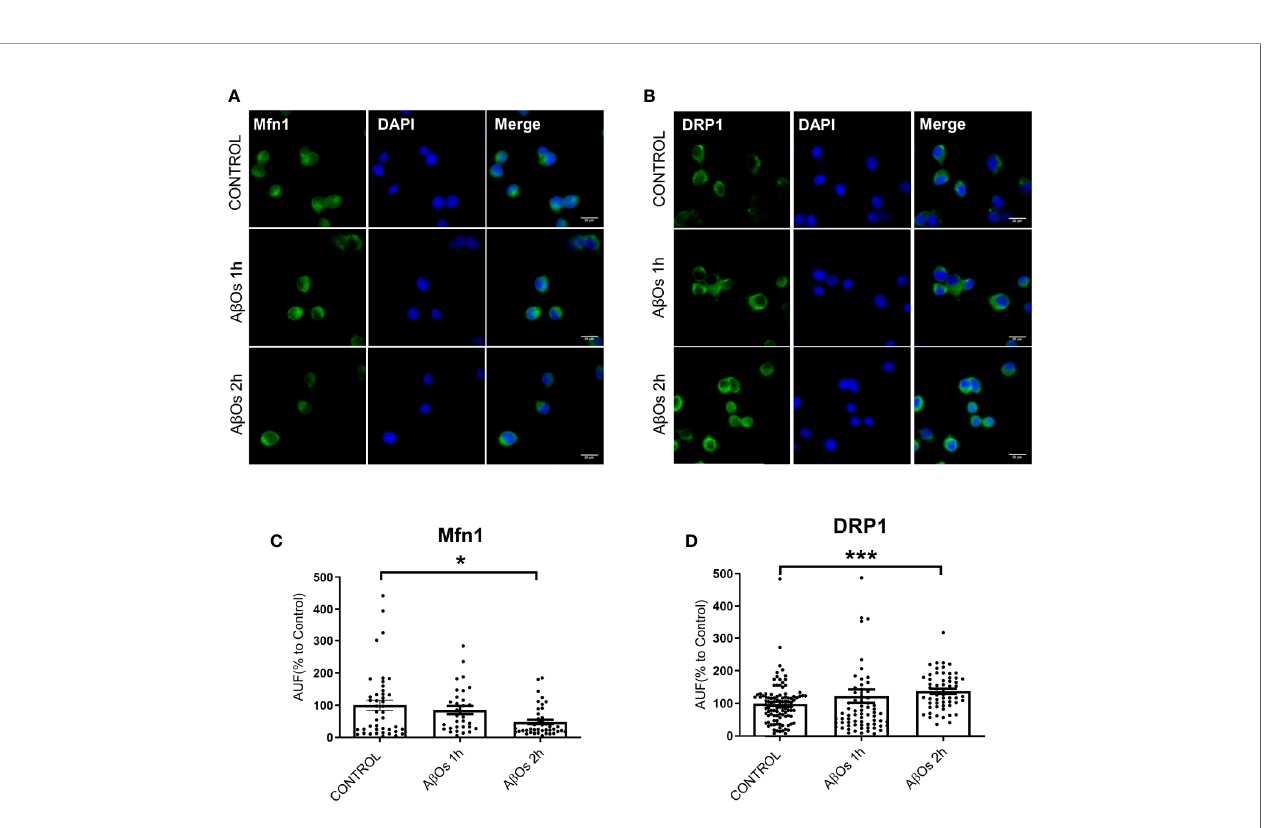
FIGURE 3 | Acute effects of A b Os on immunoreactivity of proteins that regulate mitochondrial dynamics. Representative epi fl uorescence images of (A) Mfn1 and (B) DRP1 immunoreactivity in PC-12 cells control and treated with A b Os (0.5 m M) for 1 and 2 h. Quanti fi cation of (C) Mfn1 and (D) DRP1 immunoreactivity (intensity), under the same experimental conditions. Scale bars: 20 m m. Data are represented as mean ± SEM. *p < 0.05, ***p < 0.001 compared between the control group. One-way ANOVA with the Dunn's multiple comparisons test was used for all statistical analyses. Mfn1, mitofusin 1; DRP1, dynamin-related protein 1. (n=3 – 6 for each group, N= 56 – 103) (entire inmunocytochemistry for Mfn1 and DRP1 with control are provided on Supplementary Figure 3